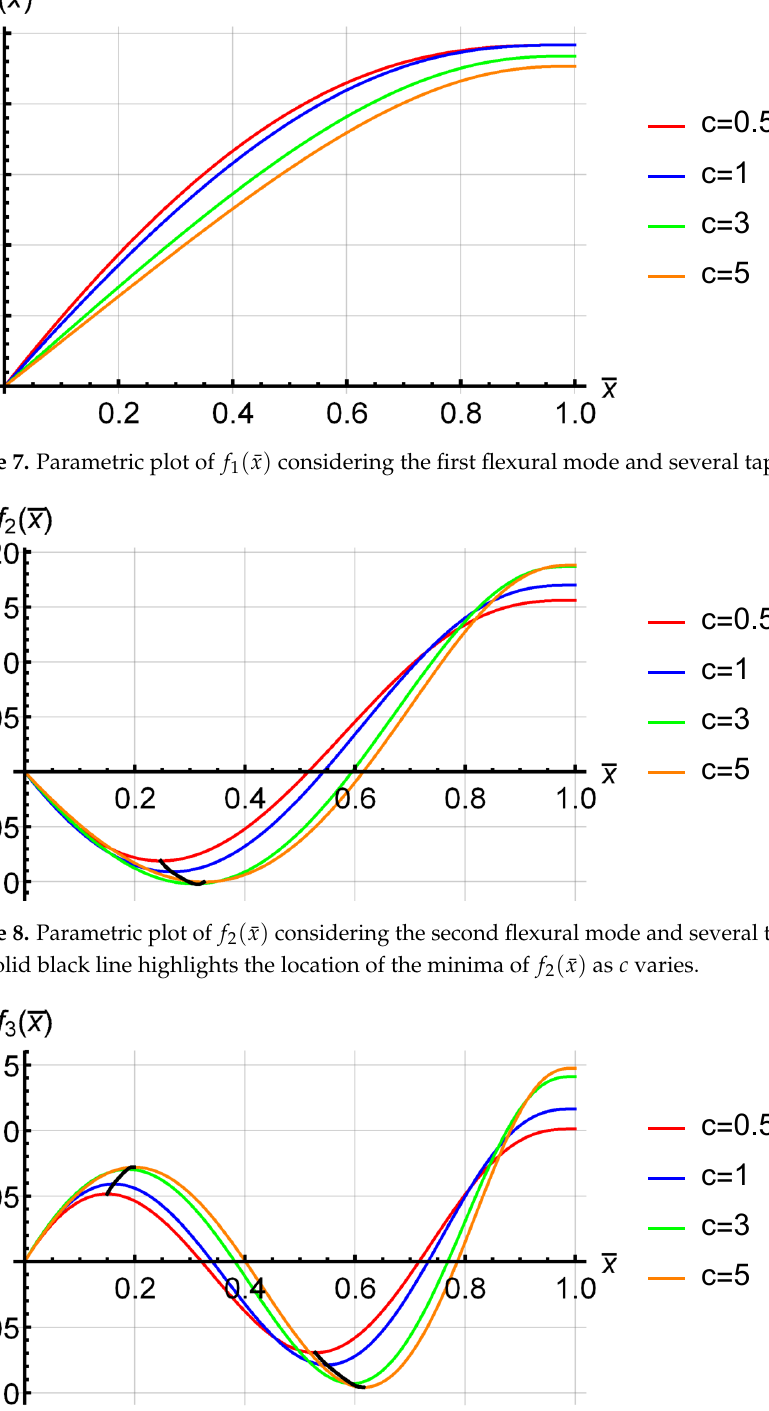
Figure 9. Parametric plot of f 3 ( ¯ x ) considering the third flexural mode and several tapering ratios c . The solid black lines highlight the location of the extrema of f 3 ( ¯ x ) as c